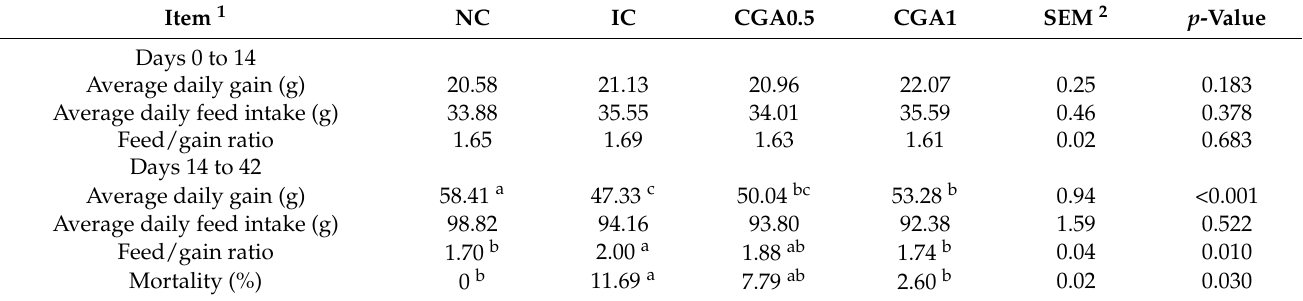
Table 2. Effects of chlorogenic acid (CGA) on the growth performance of broilers ( n = 6).